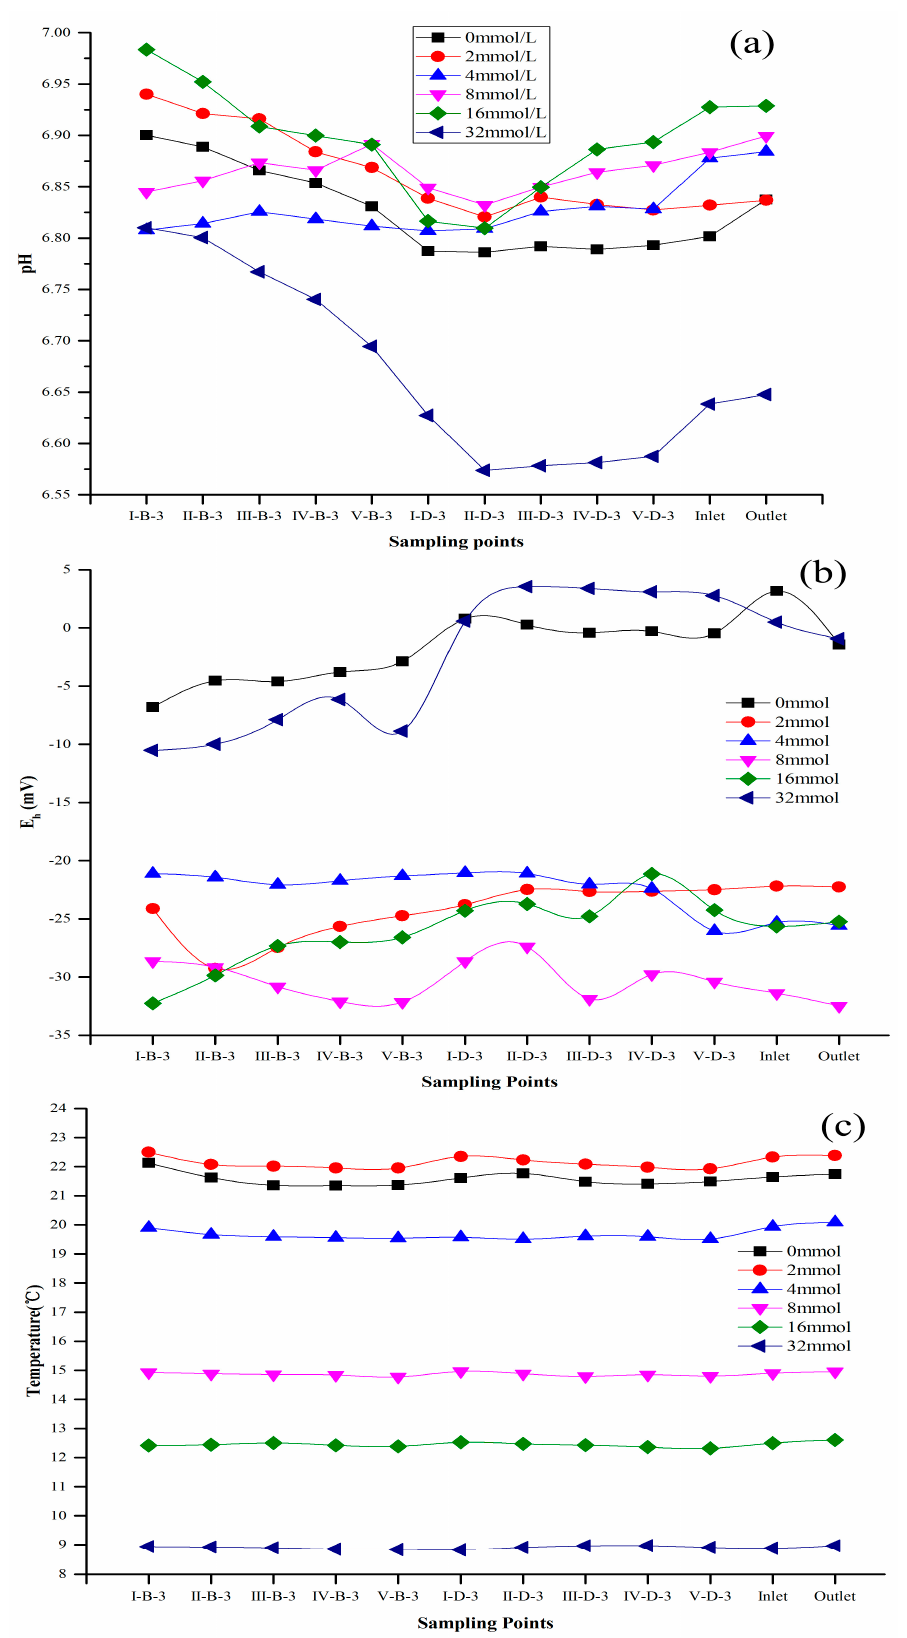
Figure 3. The parameters of sampling points in the IVCW ( a ) pH, ( b ) Eh, ( c ) temperature.